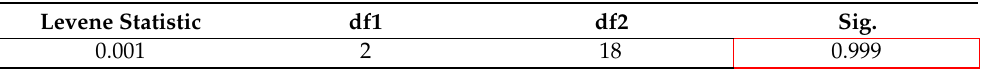
Table 2. Results of the test for equality of variance (average prediction time for each subject).